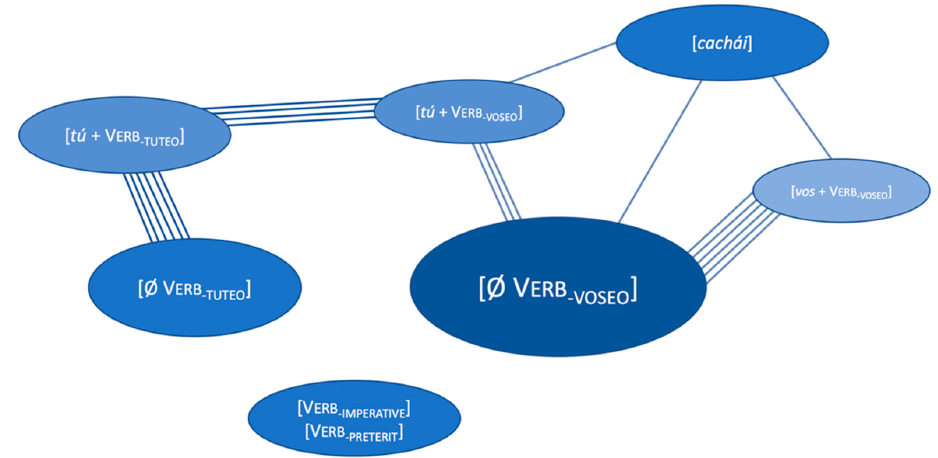
Figure 7. Mental representation of tuteo/voseo constructions.